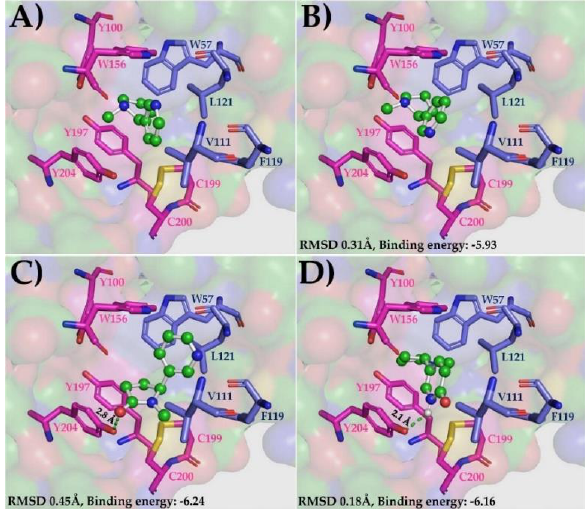
Figure 3. The native position of the NIC molecule in the α4-β2 site of α4β2 nAChRs (3α:2β, 6CNK) ( A ) and the best theoretical binding positions of (S)-nicotine ( B ), (S)-cotinine ( C ) and (S)-6-hydroxynicotine ( D ). The ligands are displayed as ball and sticks, the NIC-binding site-residues are shown as sticks (the residues with side chain colored in magenta belong to α 4 subunit while the residues with side chain in dark blue belongs to β 2 subunit), the hydrogen bonds are represented as green dashed lines and the rest of the receptor as molecular